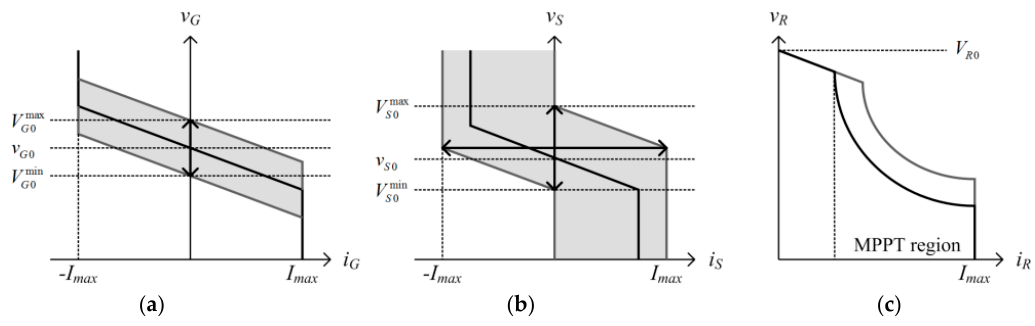
Figure 2. Droop characteristics in V–I curves of ( a ) grid-interfaced converter (GC); ( b ) storage converter (SC); and ( c ) renewable energy source (RES) converter (RC). Table 1. Operating modes of converters.